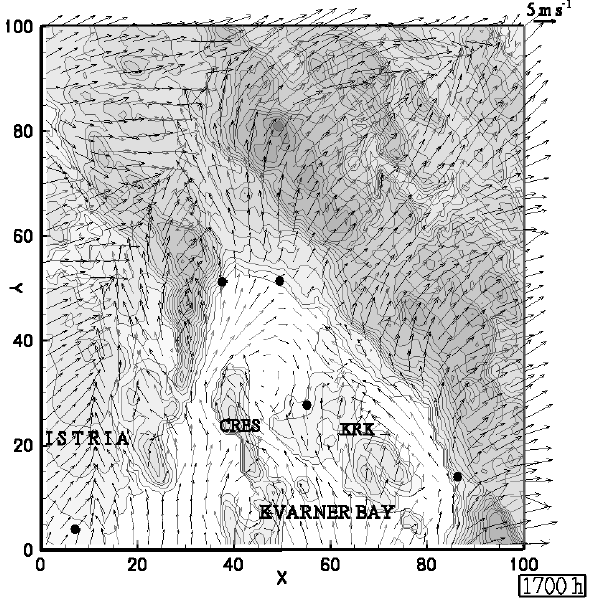
Fig. 2. Model predicted surface wind field at 10m at 17:00 local standard time on 20 June 2000 above Istria and Kvarner Bay from Prtenjak et al. (2006). The wind vectors are given at a horizontal resolution of 3km, with a reference vector drawn near the upper right-hand corner. Black dots correspond to the automatic meteoro- logical stations (numbers 1–5 in Fig.